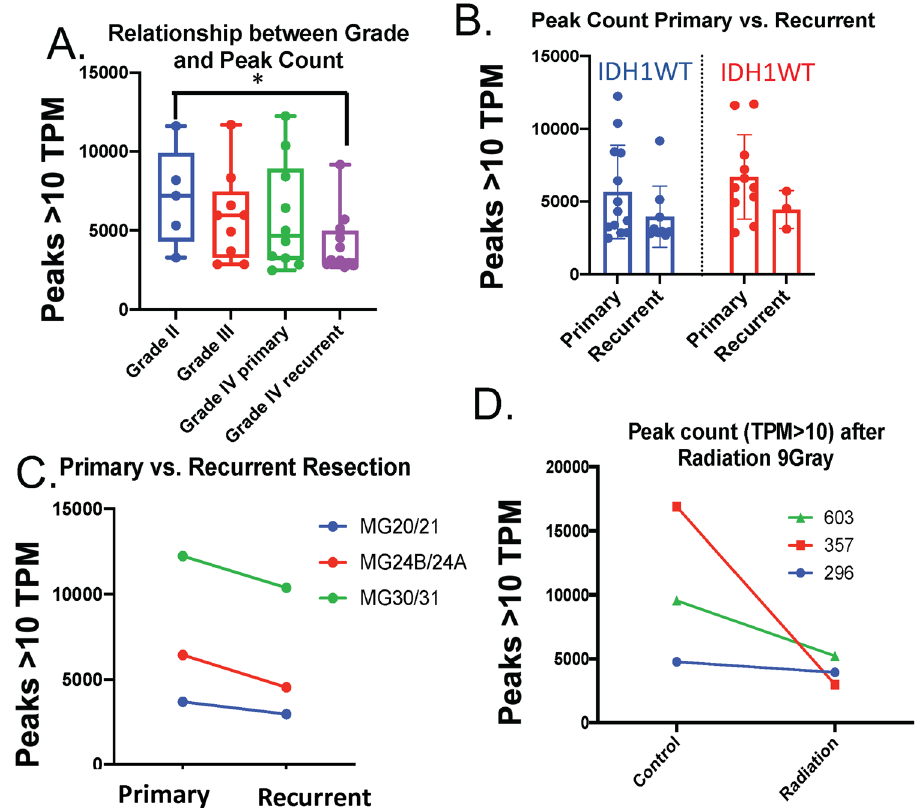
Figure 4. ( A ) The total peaks (transcripts per million > 10) were calculated for each sample and tabulated by grade. Grade II samples had significantly more peaks than Grade IV recurrent samples (ANOVA). ( B ) The total peak counts for three paired samples are shown. ( C ) Samples were divided by IDH1 status and by primary vs. recurrent status. ( D ) Three patient derived glioblastoma cell lines were subjected to atac-seq analysis before and after 9 grey radiation in three